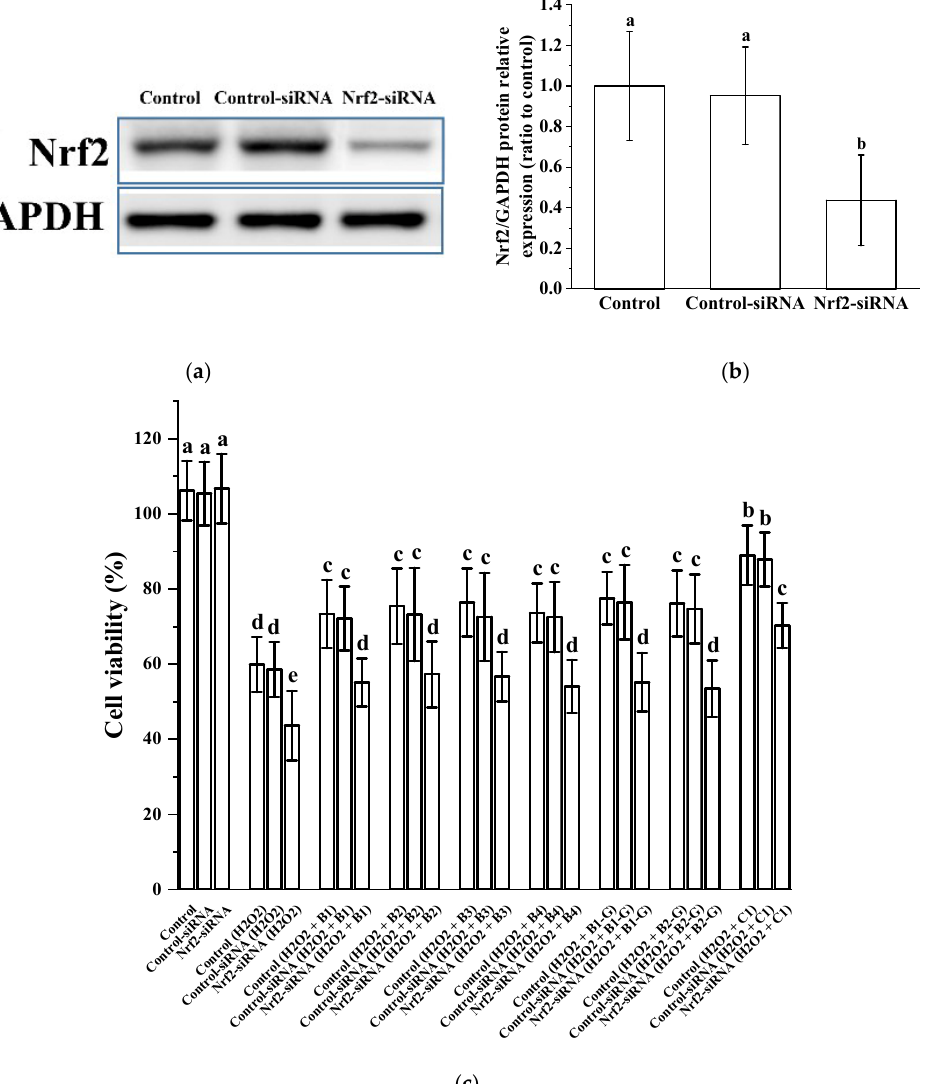
Figure 5. Verification of the role of Nrf2 in the protective effect of procyanidins with different structures. ( a ) Knockout efficiency was confirmed by determination of Nrf2 protein expression using Western blotting; ( b ) Relative Nrf2/GAPDH protein expression (ratio to control); ( c ) Cell viability. Data are shown as the mean ± SD. All experiments were conducted three times. Values with different letters are significantly different ( p < 0.05, one-way